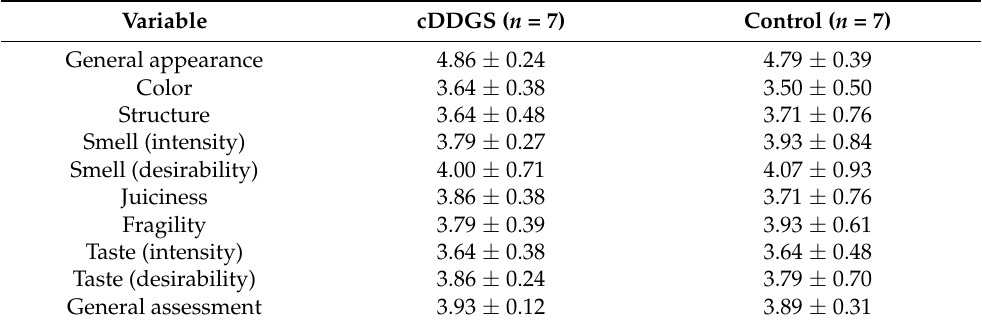
Table 9. Main sensory parameters (means ± SDs) of roasted longissimus dorsi muscle analyzed by the seven-person